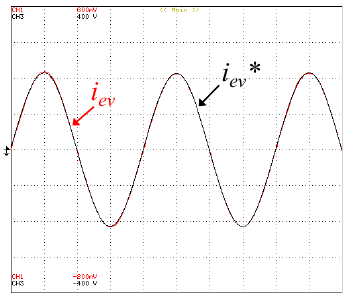
Figure 6. Experimental result showing the EV current ( i ev ) and its reference ( i ev* ) in G2V mode the